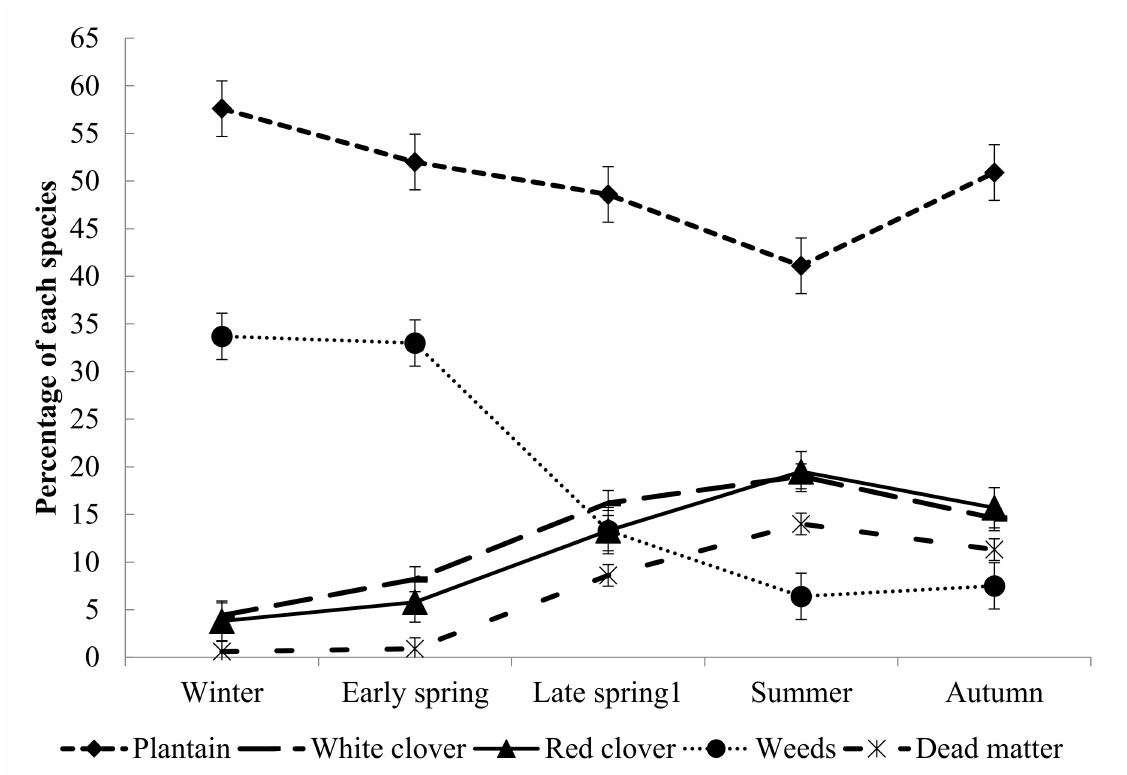
Figure 2. Botanical composition (%) within each season in the plantain mix. Late spring 1 and early summer. Vertical bars are ± SEM.